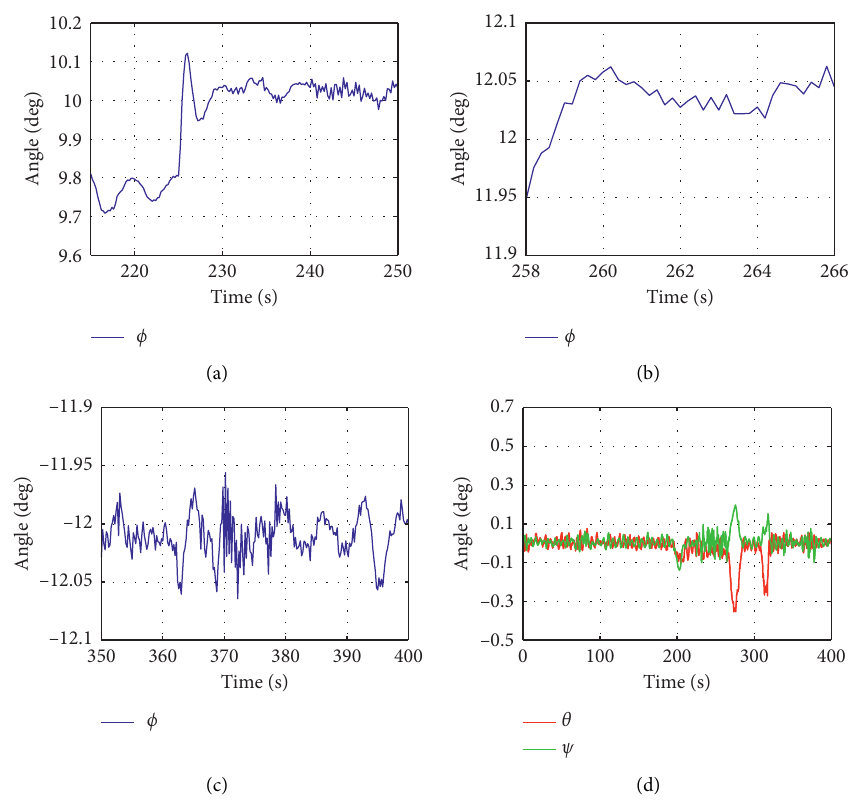
Figure 11: Local amplification of actual attitude